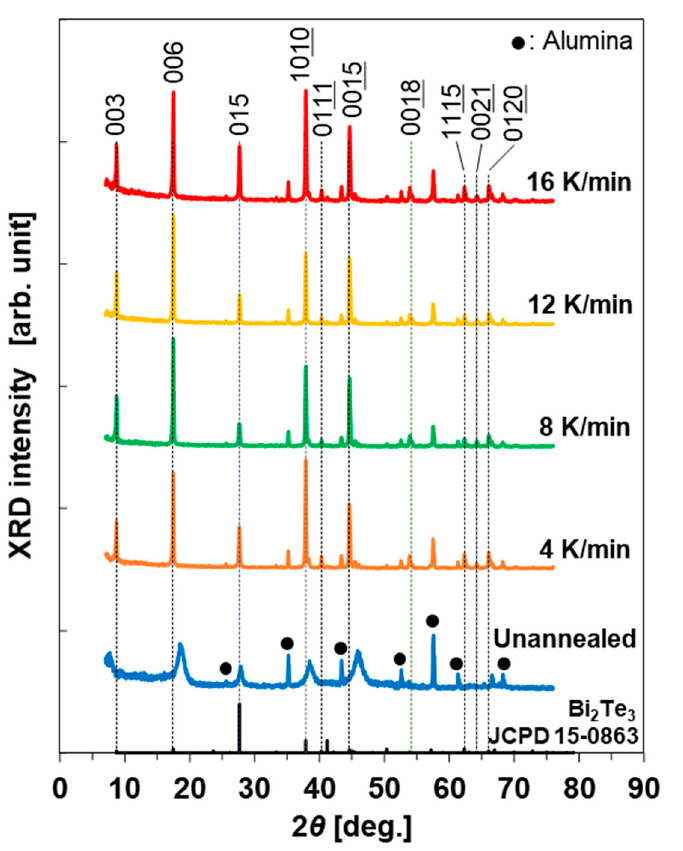
Figure 3. XRD patterns of the Bi 2 Te 3 thin films without and with heat treatment at different temperature increase rates.